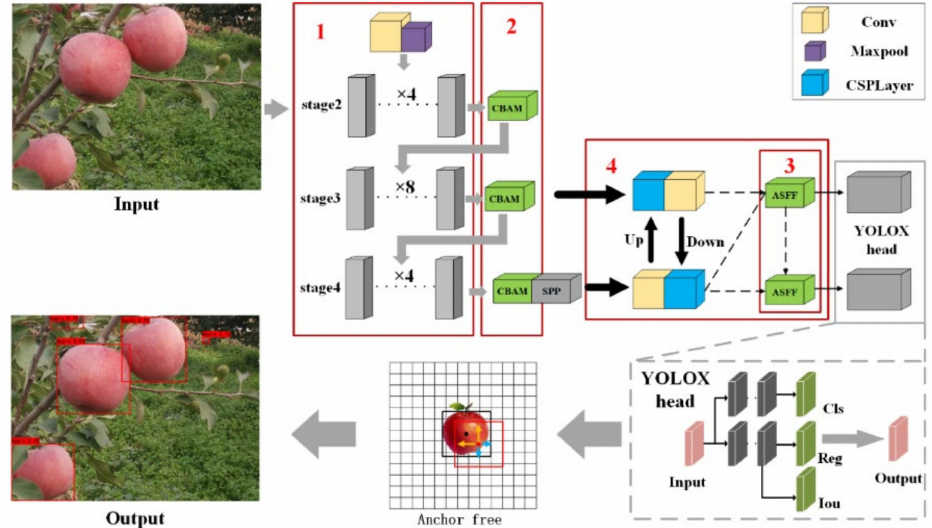
Figure 3. The network structure of ShufflenetV2-YOLOX. 1: Backbone Network Design; 2: Increase Attention Mechanism; 3: Add the ASFF Module; 4: Prune the Feature